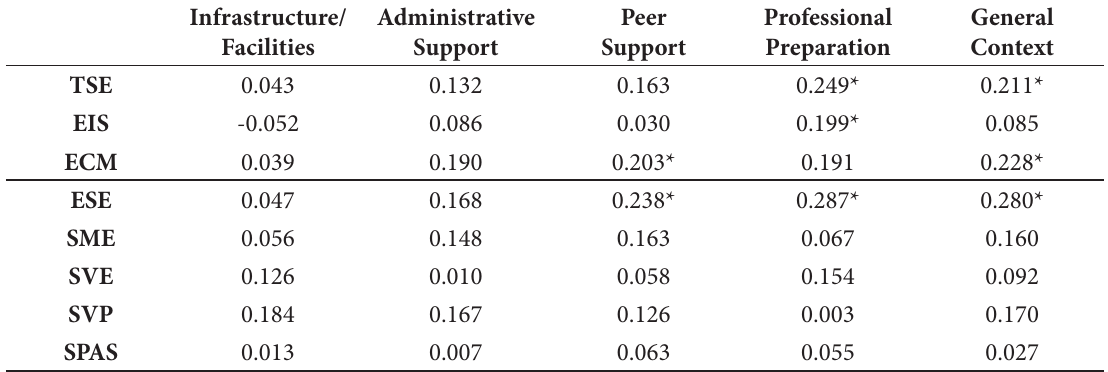
Note: r – Spearman correlation coefficient; * p <